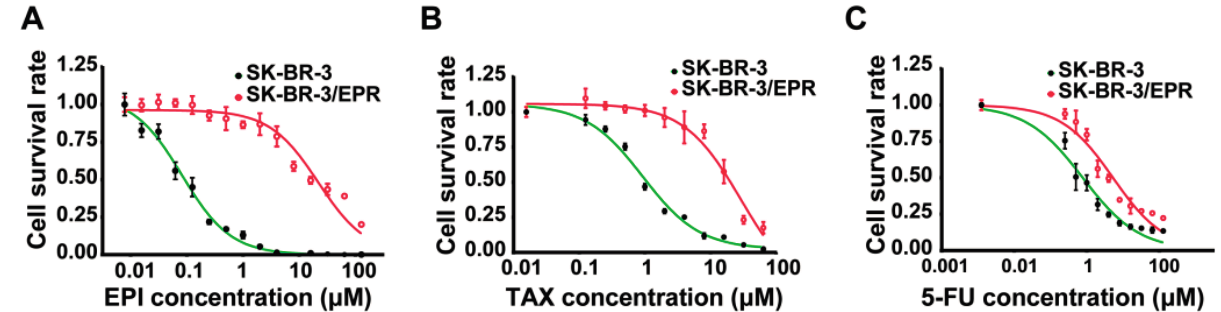
Figure 1. Establishment of a multi-drug resistant human breast cancer cell line